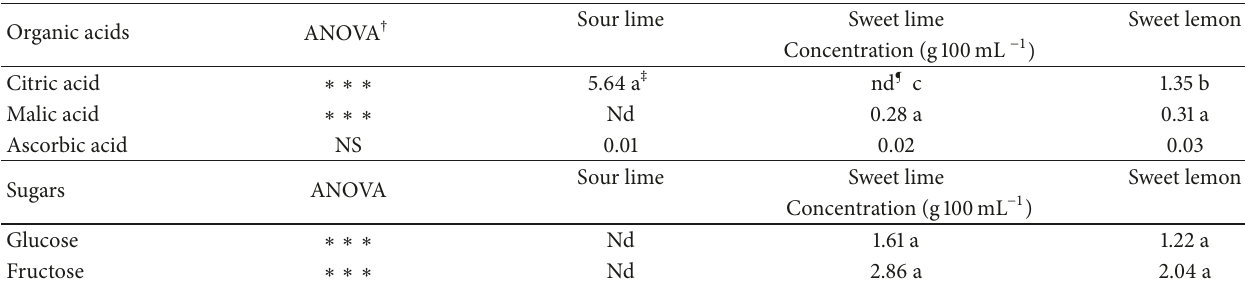
Table 2: Concentrations of organic acids and sugars in endangered Spanish lime and lemon samples. Organic